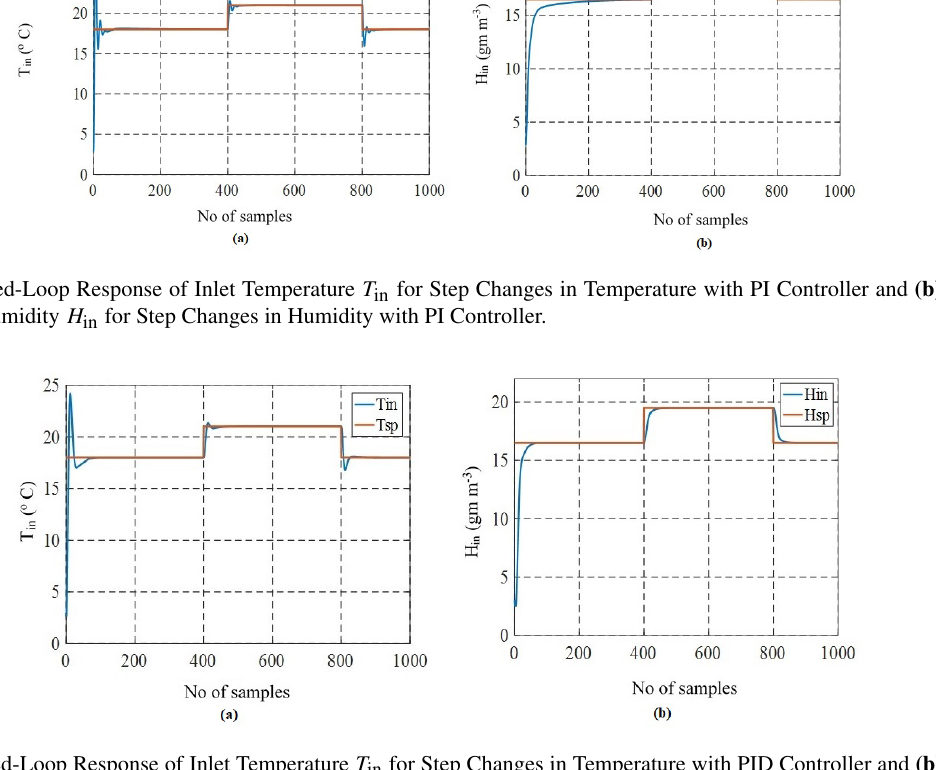
Figure 15. (a) Closed-Loop Response of Inlet Temperature T in for Step Changes in Temperature with PID Controller and (b) Closed-Loop Response of Inlet Humidity H in for Step Changes in Humidity with PID Controller.